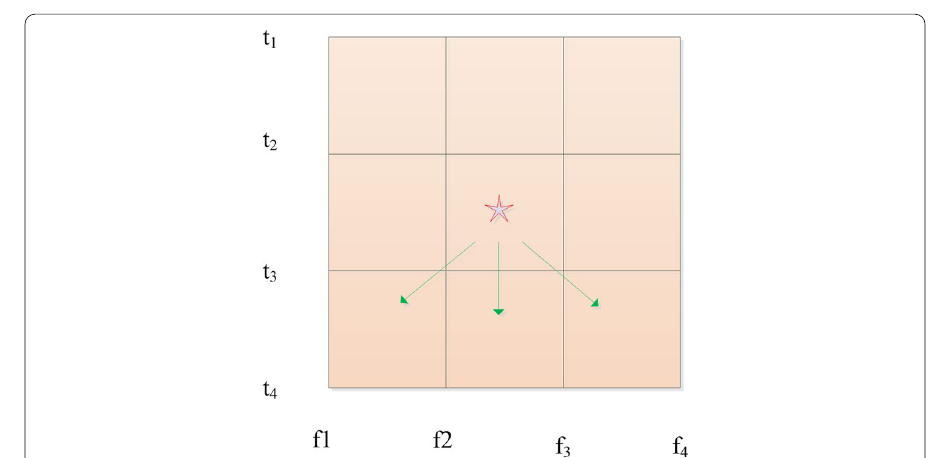
Fig. 2 Available search directions for ants in